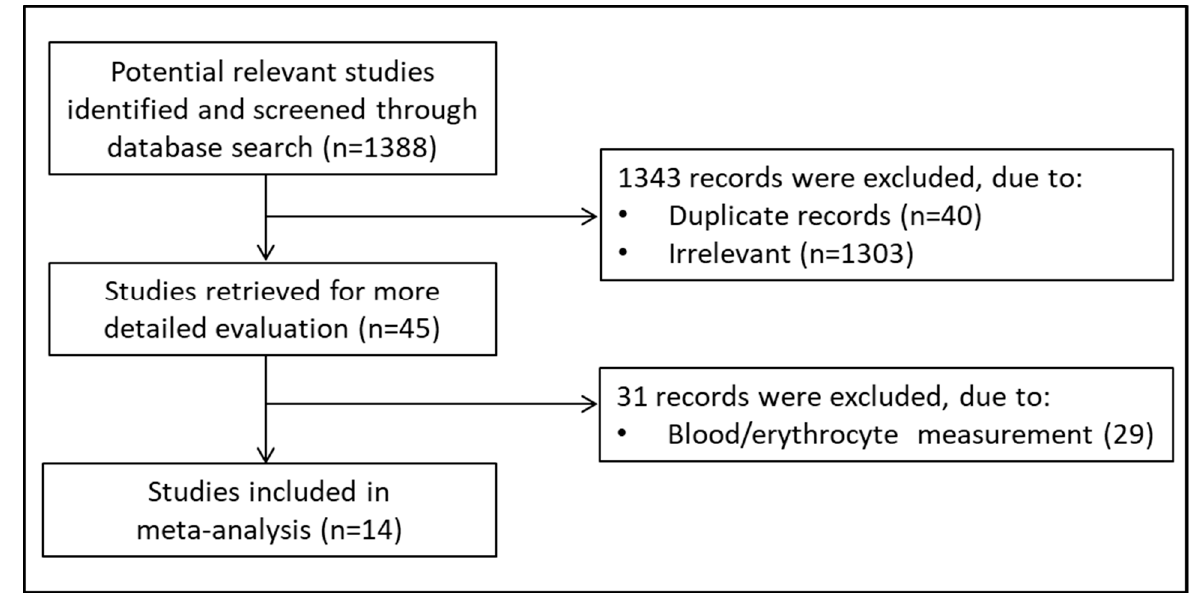
Figure 1. Flowchart of study selection. Table 1. Summary of the studies on chronic obstructive pulmonary disease (COPD) vs. controls included in the study.